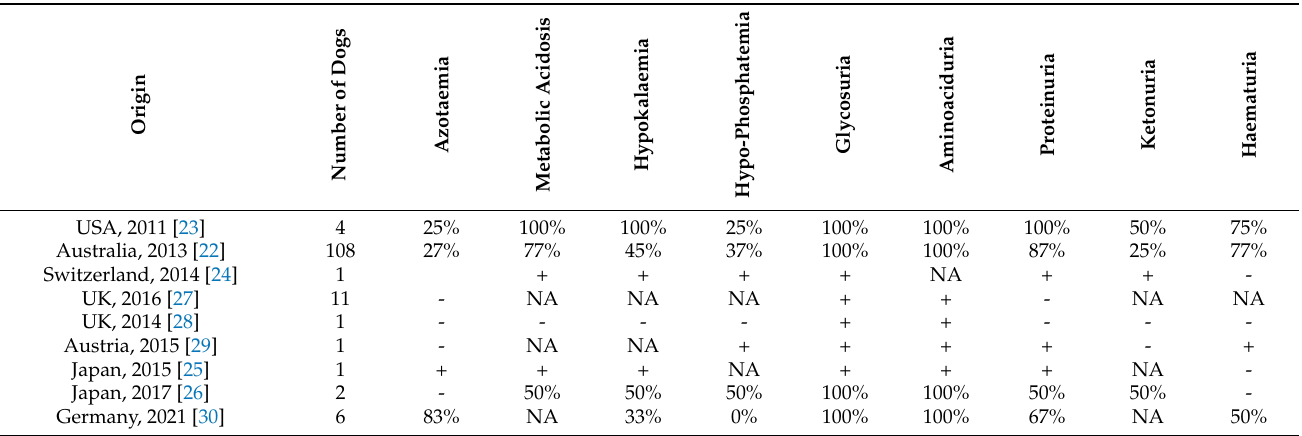
Table 1. Previously reported para-clinical abnormalities and outcome of jerky induced Fanconi